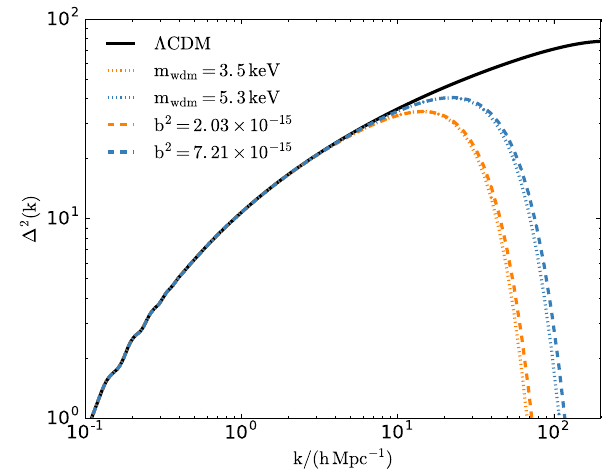
Fig. 6 Fitting formula for the WDM mass particle (in keV ) in terms of the RRG parameter b 2 values for the b 2 ,